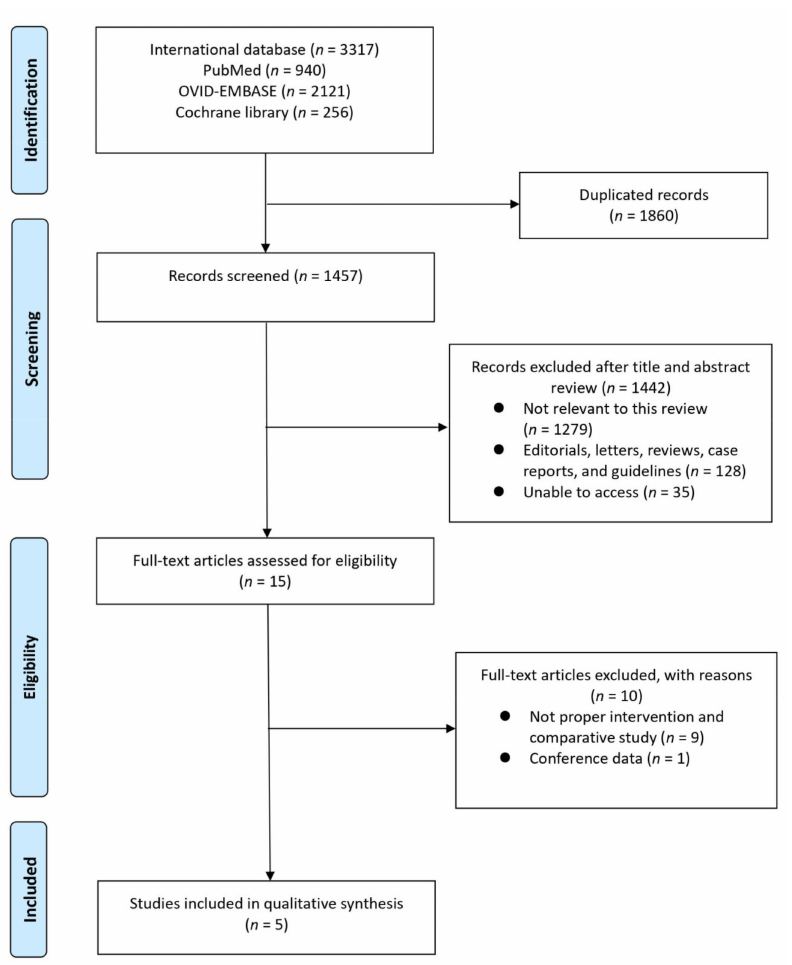
Figure 1. Study selection flowchart according to the Preferred Reporting Items for Systematic Reviews and Meta-analysis